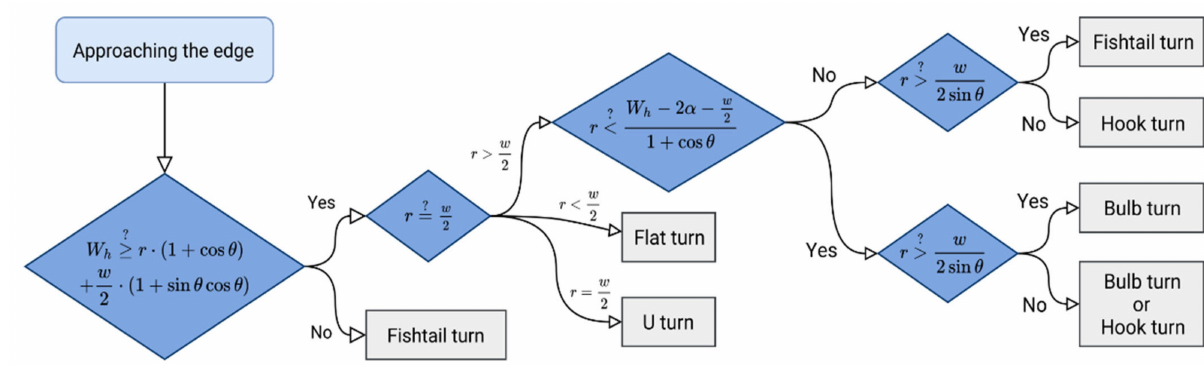
Figure 1. Decision tree for selecting the most suitable type of rotation. Meanings of variables are as follows: r —radius of rotation of the vehicle, w —working width, W h —headland width, θ —swath direction, α is the angle of arch, which is a function of r , θ , and w . Adopted from: Jin and Tang